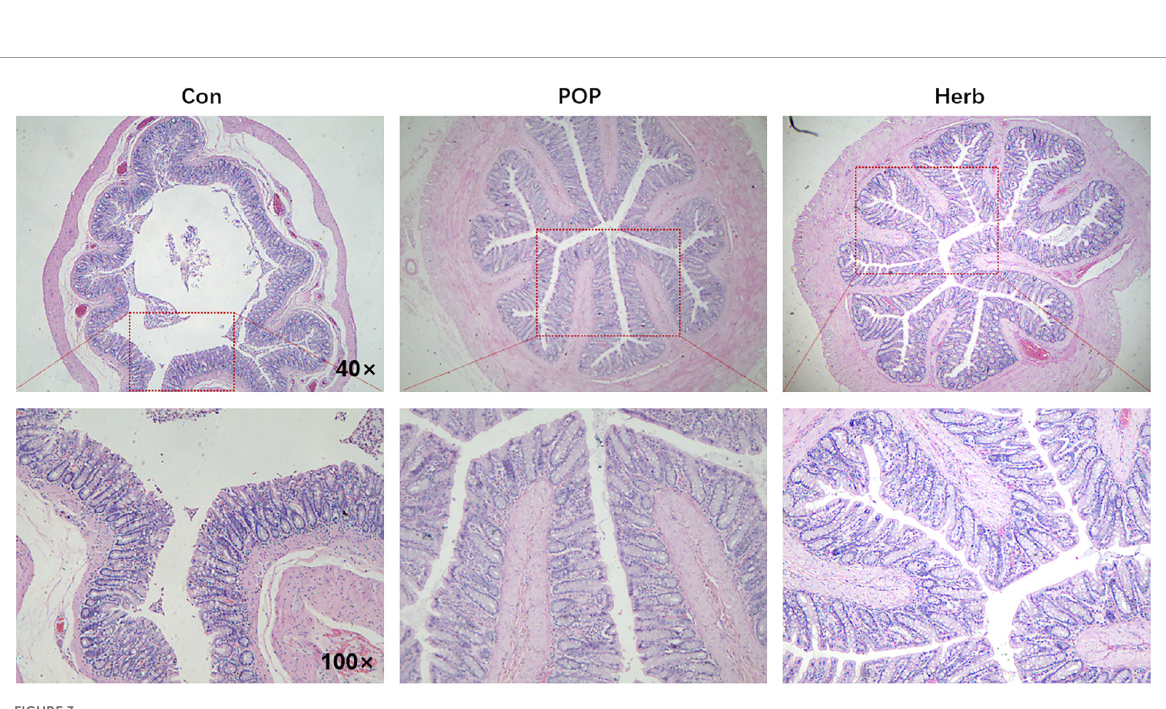
FIGURE3 H&E staining of the colon. Regular morphology and clearer and more intact structures of the colons of rats were observed in the POP and herb groups than in the Con